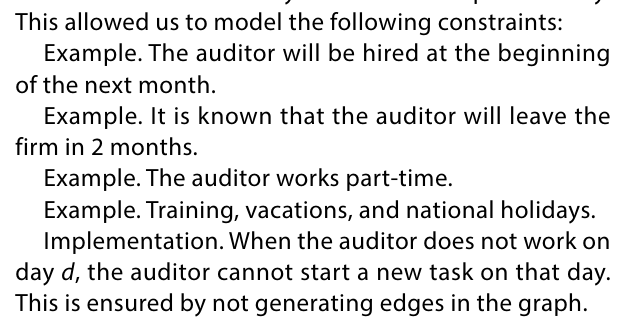
Fig. 3 Scheduling problem formulated as a flow problem